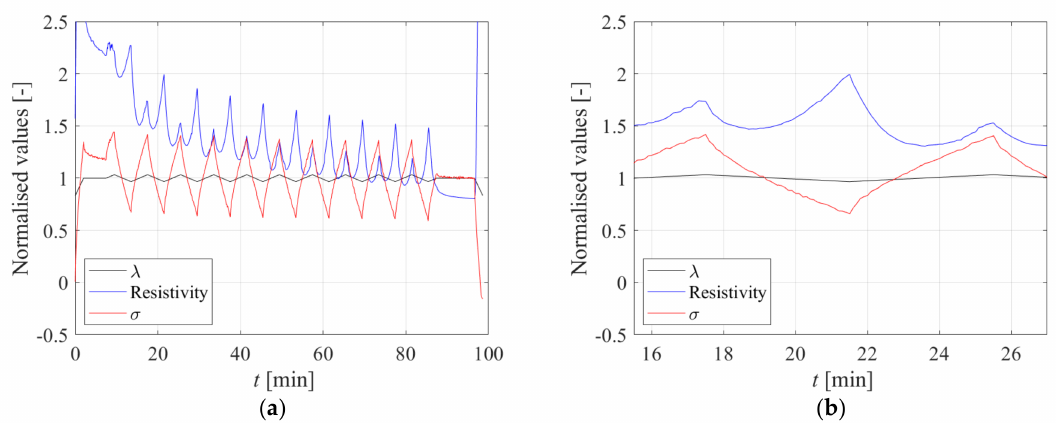
Figure 9. Resistivity and stress response due to the applied displacement pattern; ( a ) Full time history response, ( b ) Single cycle time history